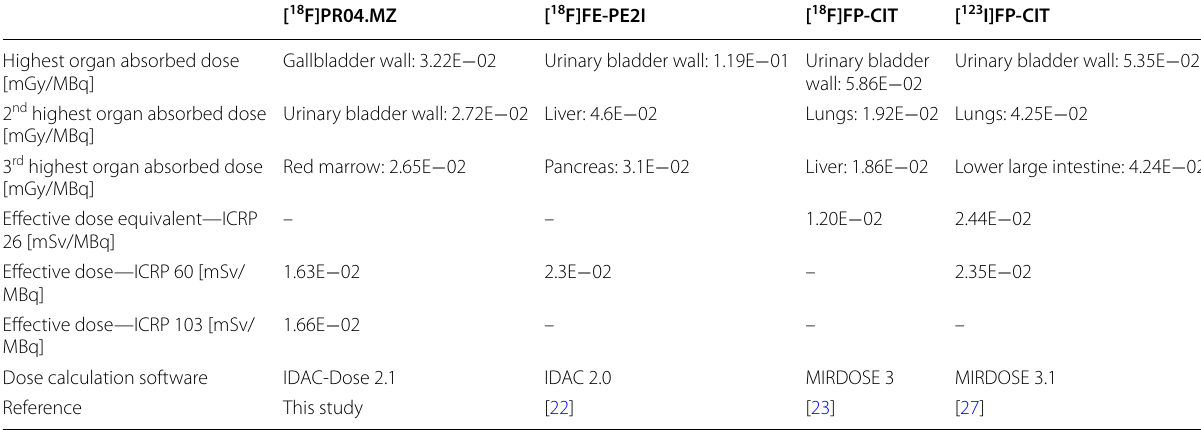
Table 4 Human dosimetry data for different DAT PET tracers compared to [ 123